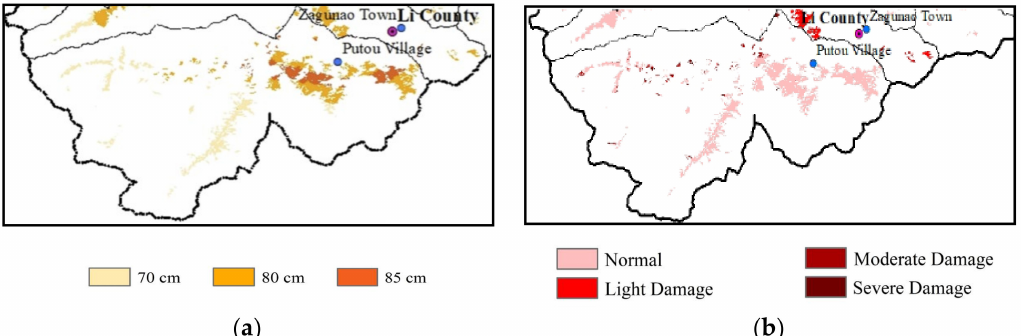
Figure 12. The relationship between soil-layer thickness and Lophodermium piceae : ( a ) the soil-layer thickness distribution of Putou Village; ( b ) the disease-investigation results of Putou